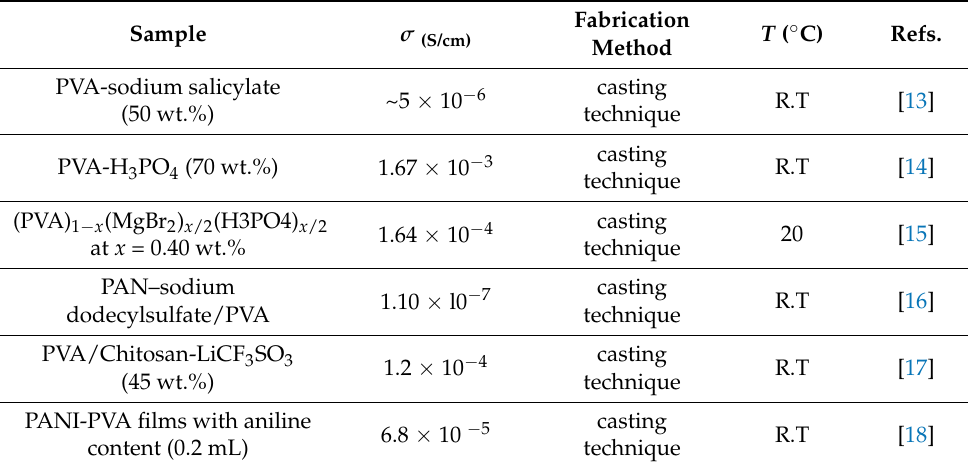
PANI-PVA films with aniline content (0.2 mL)